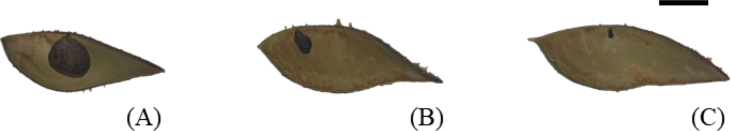
Fully developed seed (A), malformed seed (B) and aborted/unfertilized ovule (C) documented in mature fruits of Paubrasilia echinata (Leguminosae) in urban green spaces and also observed in natural area in Pernambuco State, Brazil. (Photos from urban areas) (Scale bar = 20 mm).